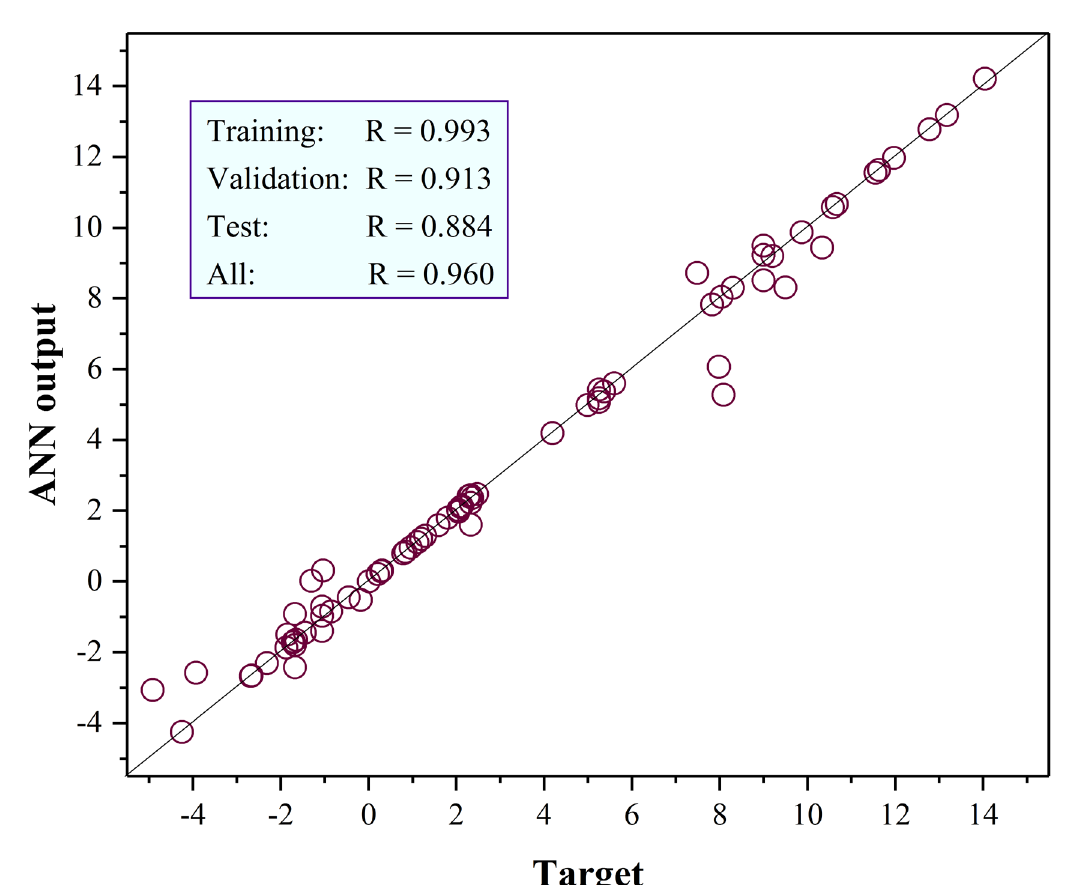
Figure 4: Optimized structure of ANN.